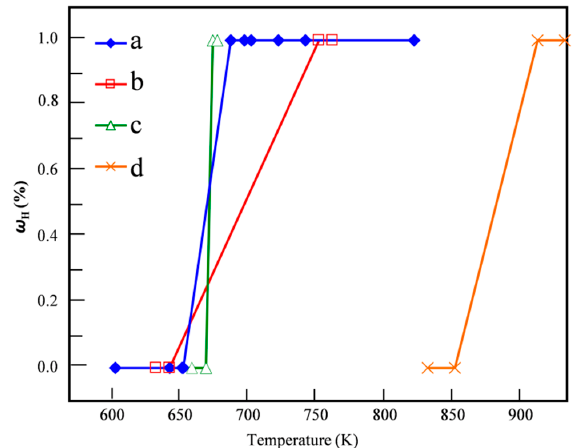
Figure 5. Hematite content produced as a product of pyrite with increasing temperature, ω H represents the mass fraction of hematite. ( a ) Present work (solid diamond). ( b ) Jorgensen and Moyle [7] (open square). ( c ) Music et al. [8] (open triangle). ( d ) Schoenlaub [6] (red cross).